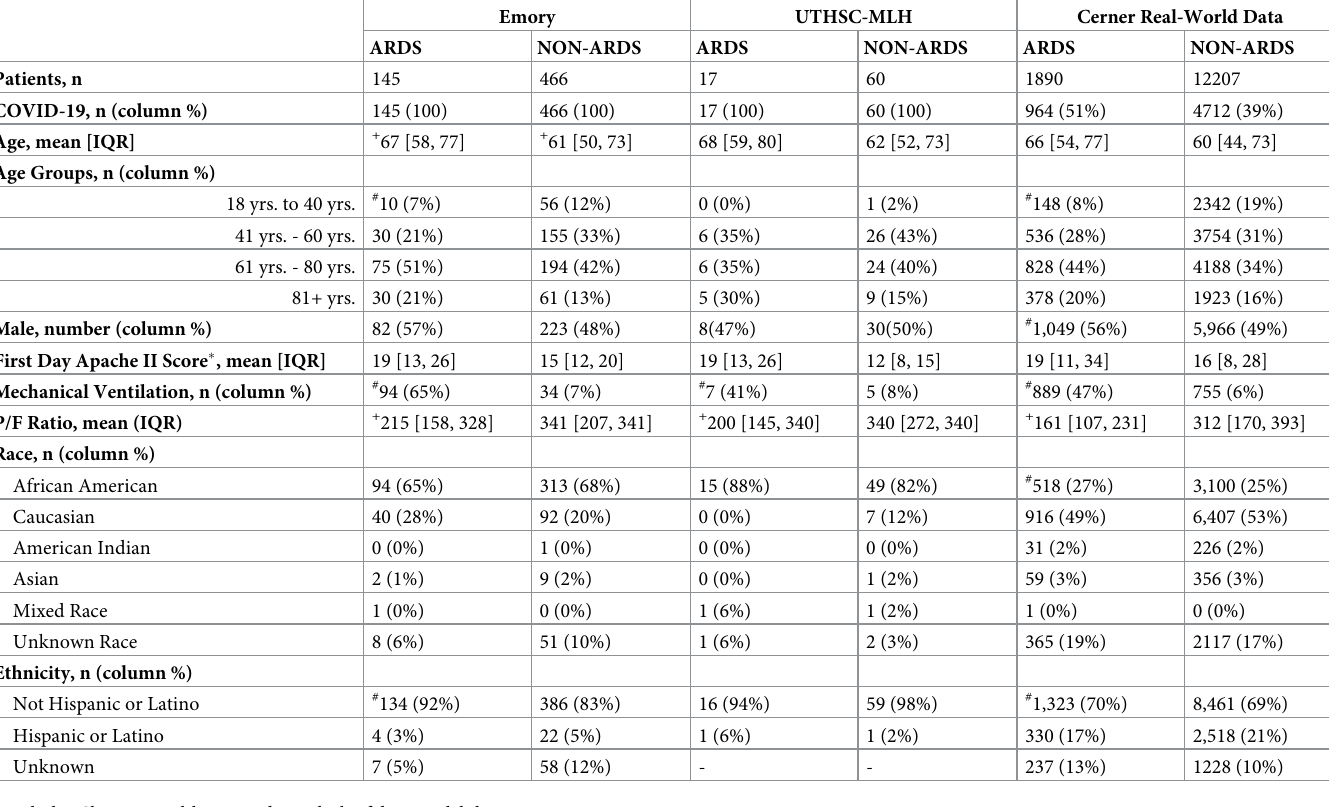
Table 1. Characteristics of patients in the